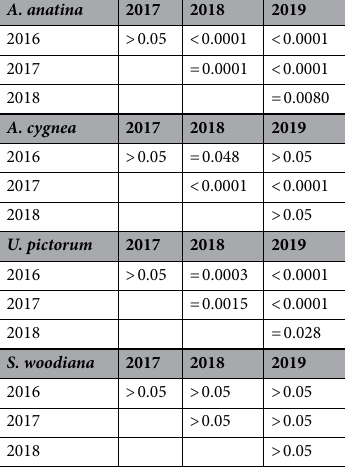
Table 2. P-values in the Kolmogorov–Smirnov test on changes in the cumulative shell-length distributions over the study period (measurements min–max normalised); Bonferroni corrected significance level, P =